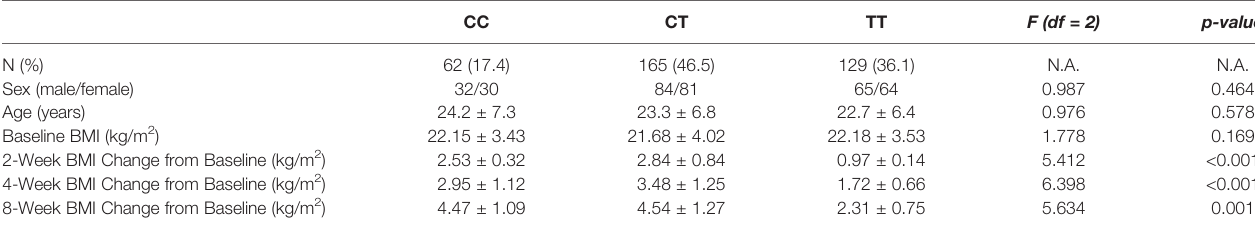
TABLE 1 | Association of MTHFR C677T polymorphism with risperidone-induced weight gain in schizophrenia.